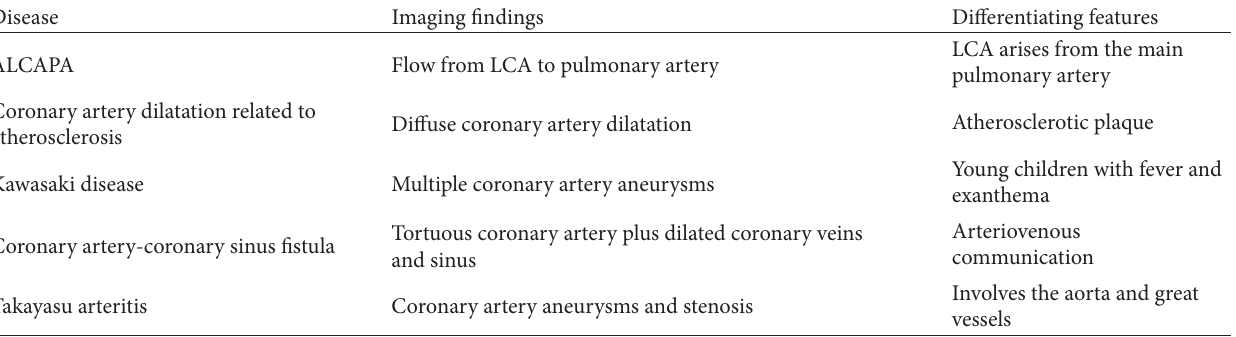
Table 1: Key distinguishing features of dilated coronary arteries (LCA: left coronary artery; RCA: right coronary artery). Adapted from Pe˜na et al.